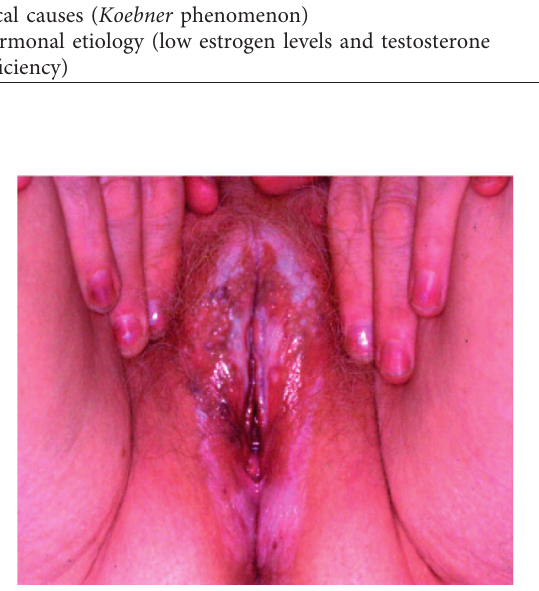
Figure 1: White patches seen in vulvar lichen sclerosus.